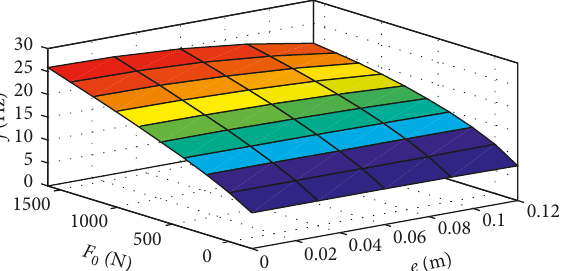
Figure 8: Natural frequency f of the beam with simply supported ends in the parameter space of F